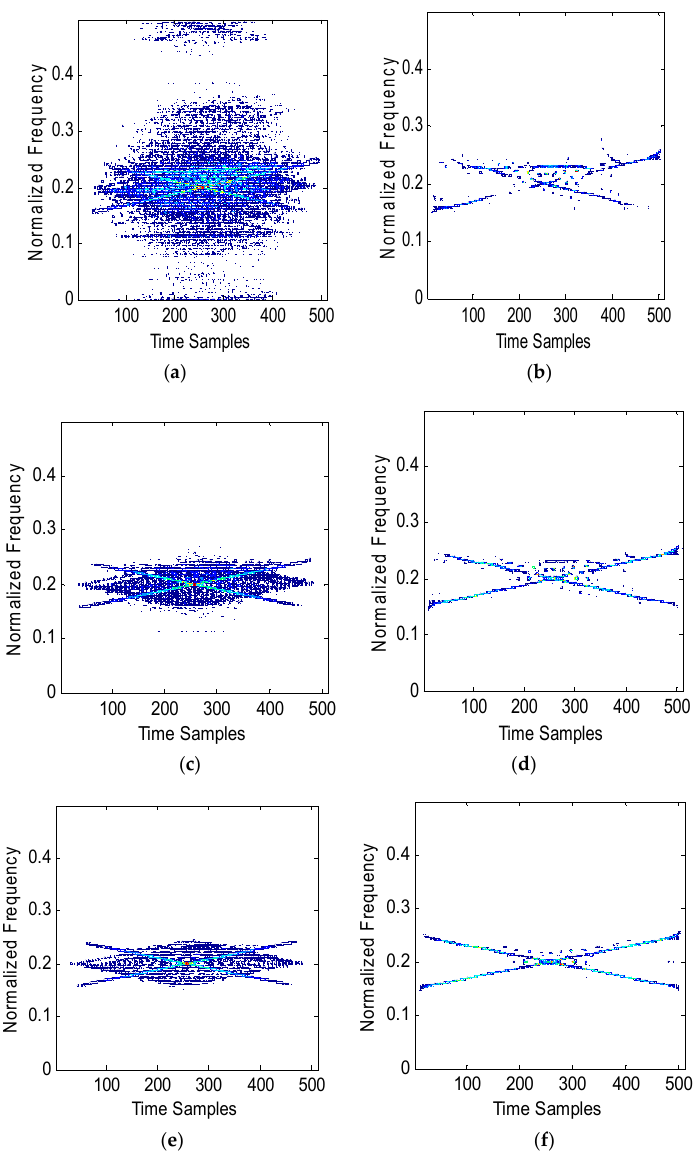
Figure 4. The WVD and RSPWVD of BDS B1I signals with two chirps, C 0 / N is 43 dB-Hz and the JNR is 0 dB, 6 dB and 12 dB. ( a ) WVD, JNR is 0 dB. ( b ) RSPWVD, JNR is 0 dB. ( c ) WVD, JNR is 6 dB. ( d ) RSPWVD, JNR is 6 dB. ( e )WVD, JNR is 12 dB. ( f ) RSPWVD, JNR is 12 dB. Table 1. Down-converter digitizer parameters.